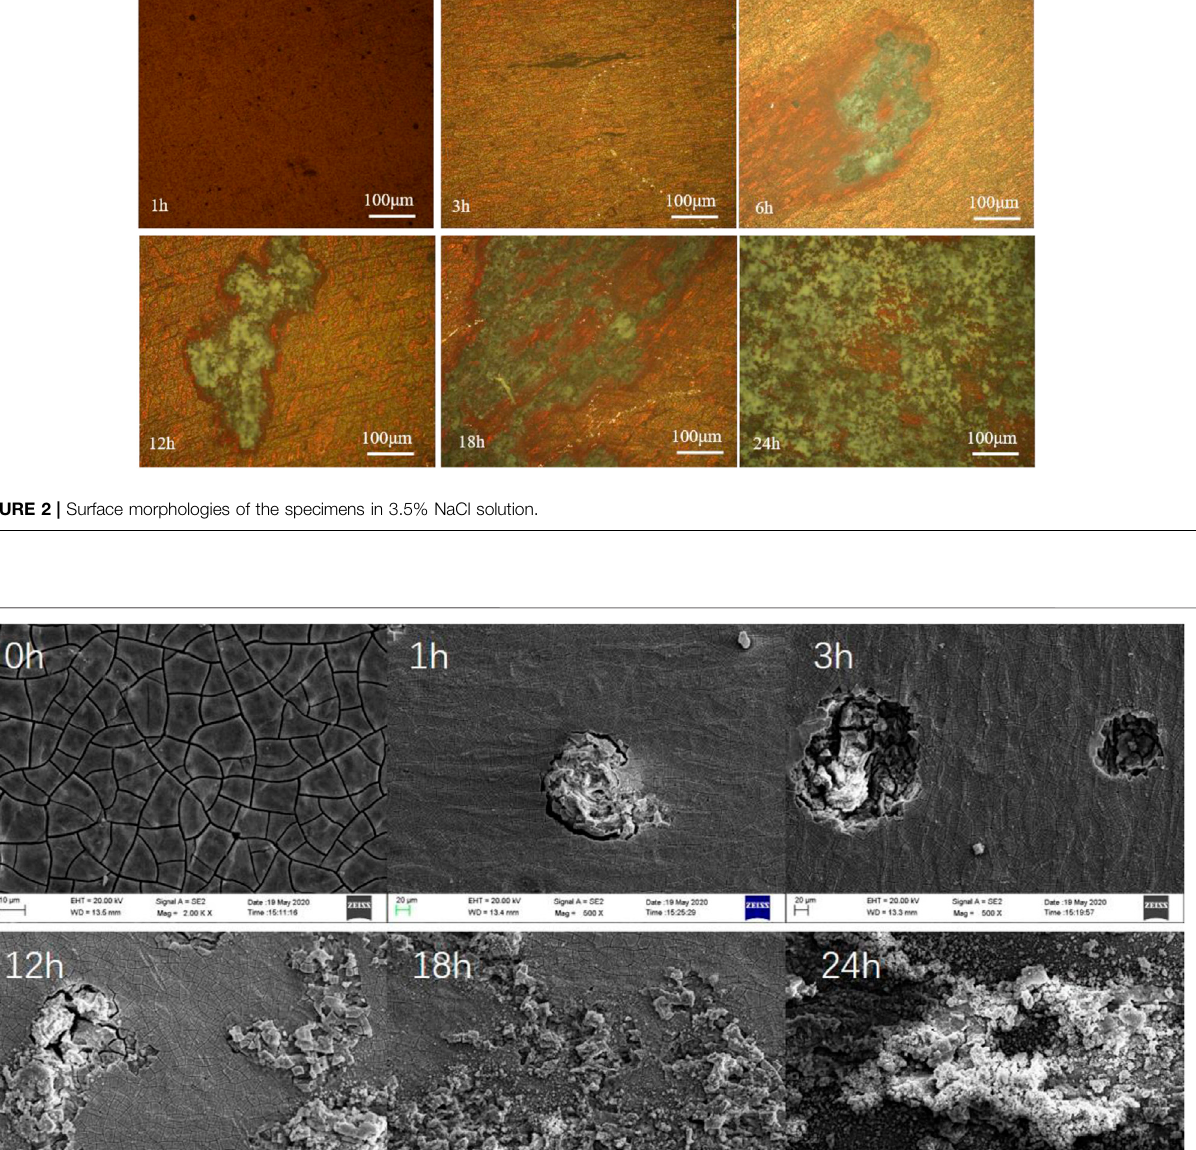
Frontiers in Materials |